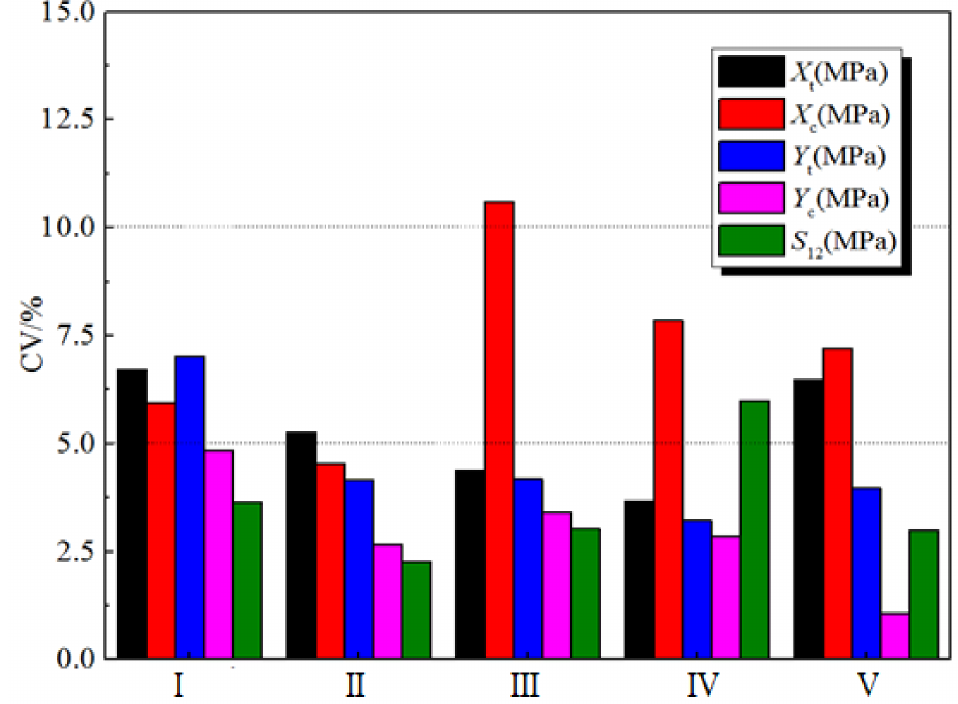
Figure 5. CV results for the strength properties of the five H-GFRP